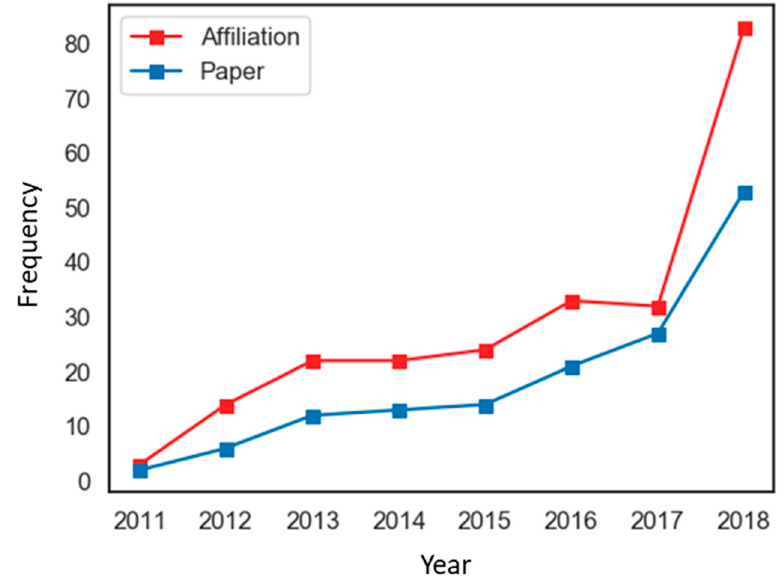
Figure Figure 3. Annual publication trends of traditional herbal medicine-network pharmacology (THM-